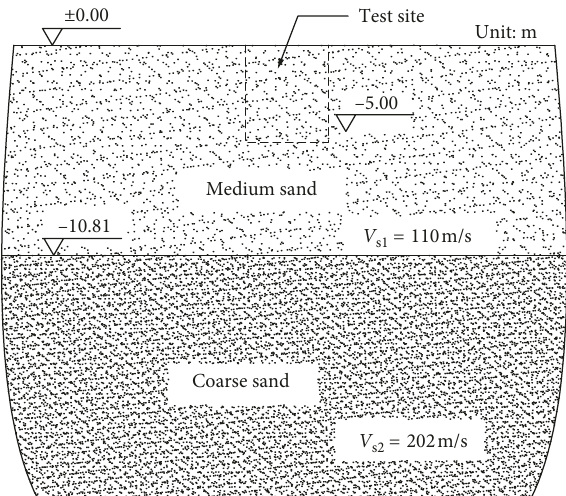
Figure 3: Distribution of soil layer in sand foundation. Table 1: Physical index of the backfilled sand.